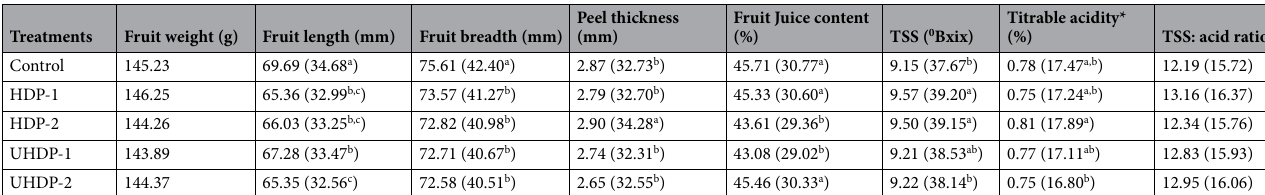
Table 5. Effect of planting density on fruit quality parameters (pooled data for 2015–16 to 2019–20). Figures under parenthesis are transformed values. Means with at least one letter common are not statistically significant using TUKEY’s Honest Significant Difference at 5% Control: Planting at 6 m (row to row) × 6 m (plant to plant) spacing (tree density—277 plants ha −1 ), HDP-1: Planting at 6 m (row to row) × 3 m (plant